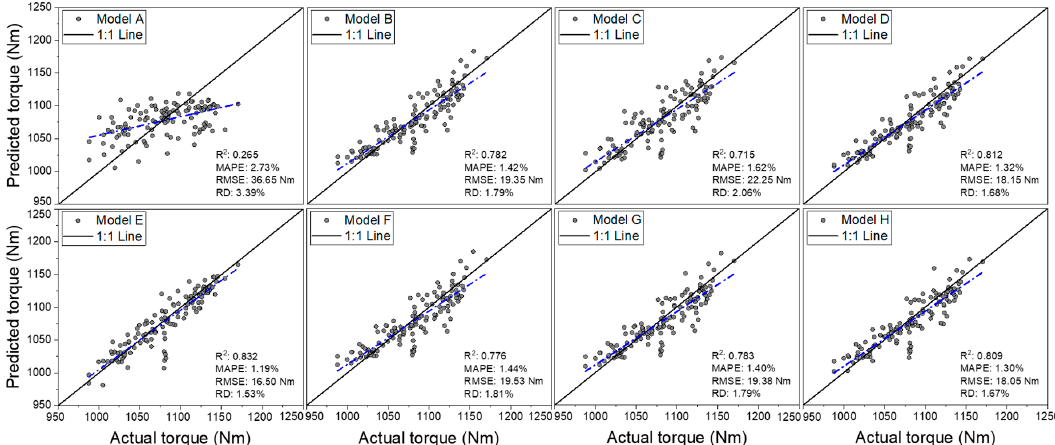
Figure 8. Relationships between the predicted and measured axle torque for each regression Model ( A – H ): Model A = axle torque as a linear function of engine torque and engine speed; Model B = axle torque as a linear function of tillage depth; Model C = axle torque as a linear function of slip ratio and travel speed; Model D = axle torque as a linear function of engine torque, engine speed and tillage depth; Model E = axle torque as a linear function of engine torque, engine speed and travel speed; Model F = axle torque as a linear function of tillage depth and travel speed; Model G = axle torque as a linear function of engine speed, tillage depth and travel speed; and Model H = axle torque as a linear function of engine torque, tillage depth and travel speed.